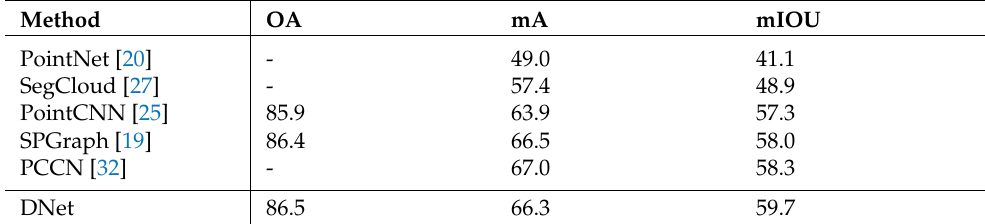
Table 6. Scene segmentation results of Area 5 in S3DIS dataset